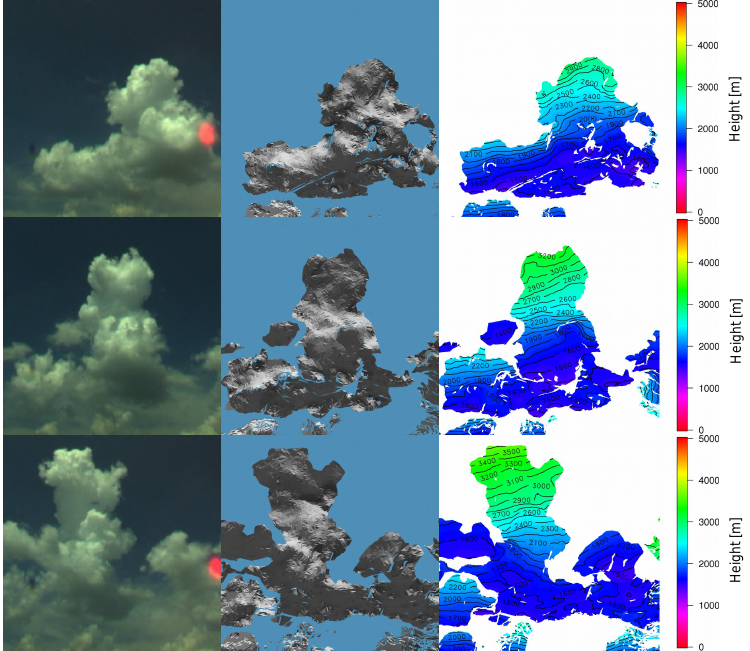
Figure 18. 3-D reconstruction of cumulus cloud from 24 July 2014, organized as in Fig. 16. Results are shown for 11:28:00UTC (top row), 11:30:00UTC (middle row) and 11:32:00UTC (bottom row). The cloud is approximately 3km away.